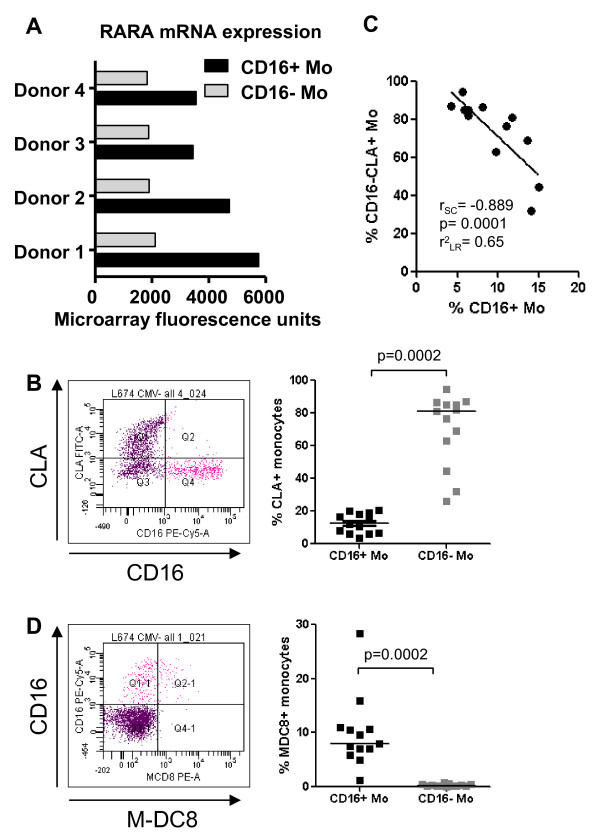
Differential expression of RARA mRNA and PSGL-1 epitopes CLA and M-DC8 on CD16+ and CD16- monocytes. (A) Differential expression of RARA mRNA in CD16+ and CD16- Mo was extracted from microarray data set results and expressed as relative fluorescence units. (B-D) Freshly isolated PBMC were stained with Pacific Blue CD3, Alexa700 CD4, PE-Cy5 CD16, FITC CLA and PE M-DC8 Abs. Gated CD3-CD4lowCD14highCD16- (CD16- Mo) and CD3-CD4lowCD14lowCD16+ (CD16+ Mo) cells were analyzed for expression of CLA (C) and M-DC8 (D). (B and D) Shown are representative dot plots (left panels) and results for 13 different donors (right panels). Paired Wilcoxon signed rank test was used to calculated statistical significance (p < 0.05). (B) Spearman correlation (r and p values) and linear regression (r2 value) were calculated to examine the relationship between the frequency of CD16-CLA+ Mo and CD16+ Mo.